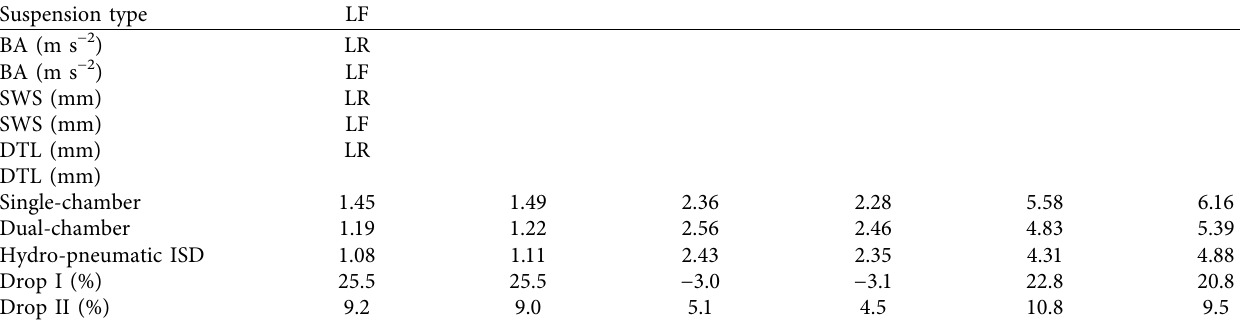
Table 4: RMS values of random input response for